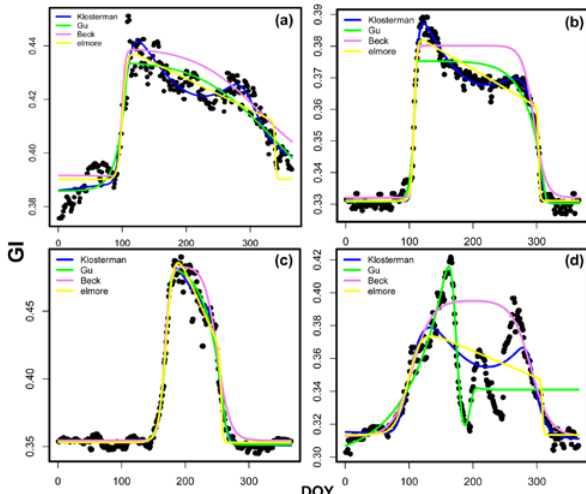
Figure 6. Effect of different combination methods on different vegetation types ((a) woodland, freemanwood, 2013; (b) forest, morganmonroe, 2016; (c) corn, kelloggcorn, 2016;(d) grass, freemangrass,